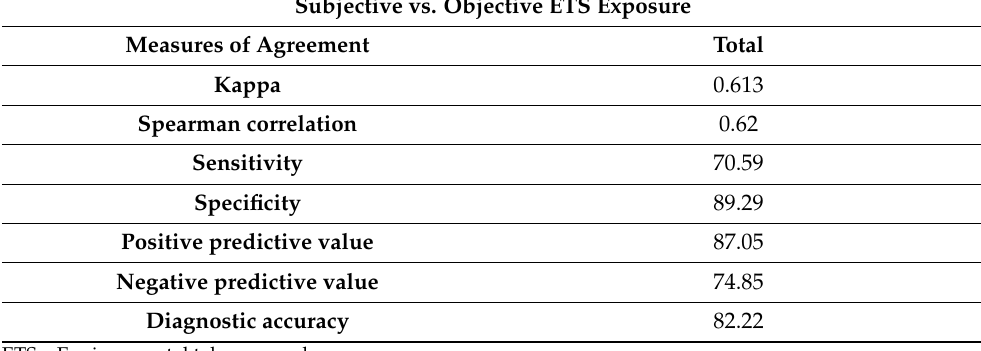
Table 5. Agreement between subjective assessment of ASD and non-ASD group children’s ETS exposure based on parental statements and objective assessment by accurate determination of cotinine concentration in urine ( n = 45).